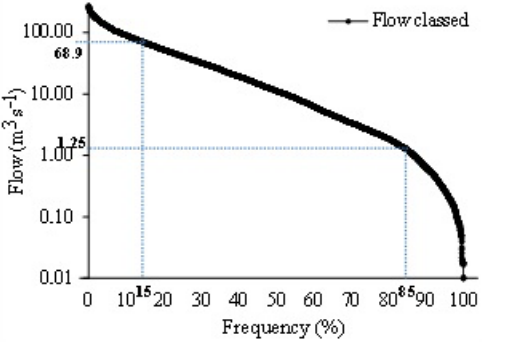
Figure 2. Flows duration curve on the Bianouan hydrometric sta- tion